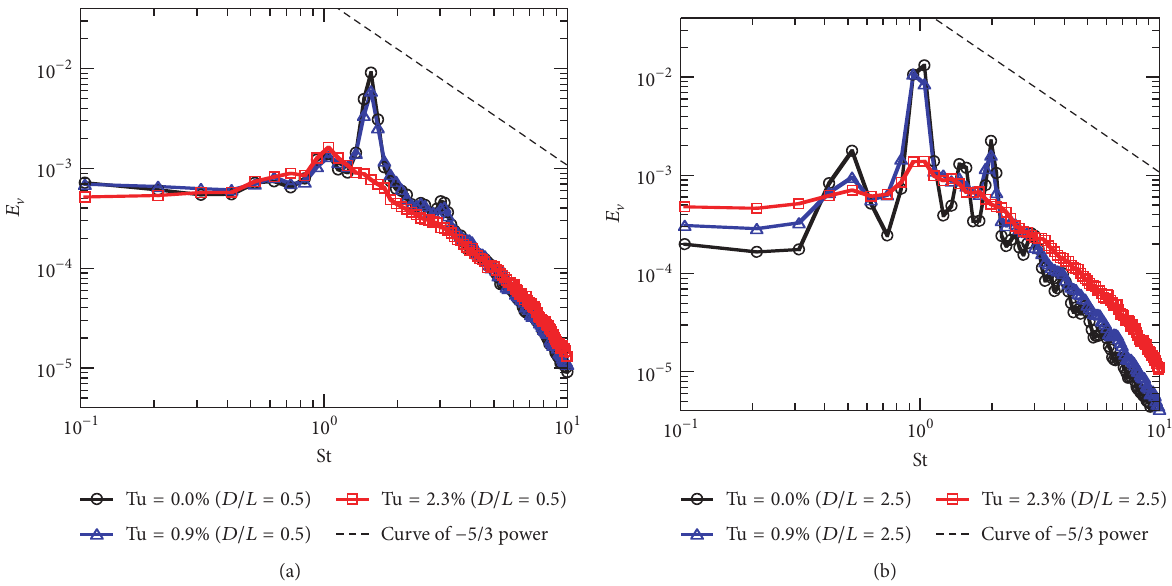
Figure 18: Power spectra of velocity V /𝑈 ∞ ( 𝑥/𝐿 = 0.9 and y = 0). (a) Cavity flow without acoustic resonance ( 𝐷/𝐿 = 0.5). (b) Cavity flow with acoustic resonance ( 𝐷/𝐿 = 2.5).